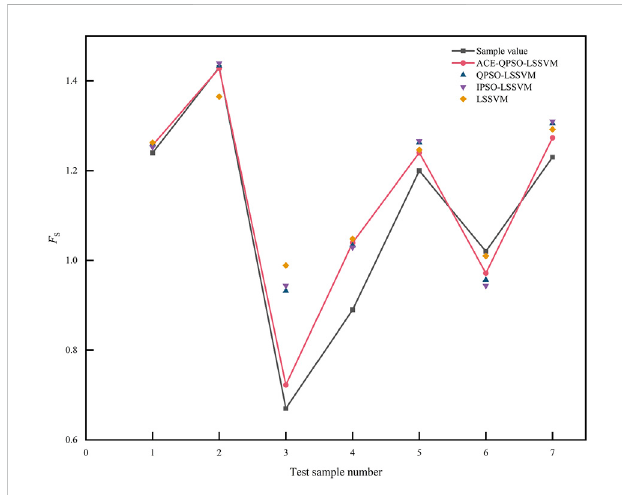
FIGURE 7 Comparison of the training results of each algorithm.